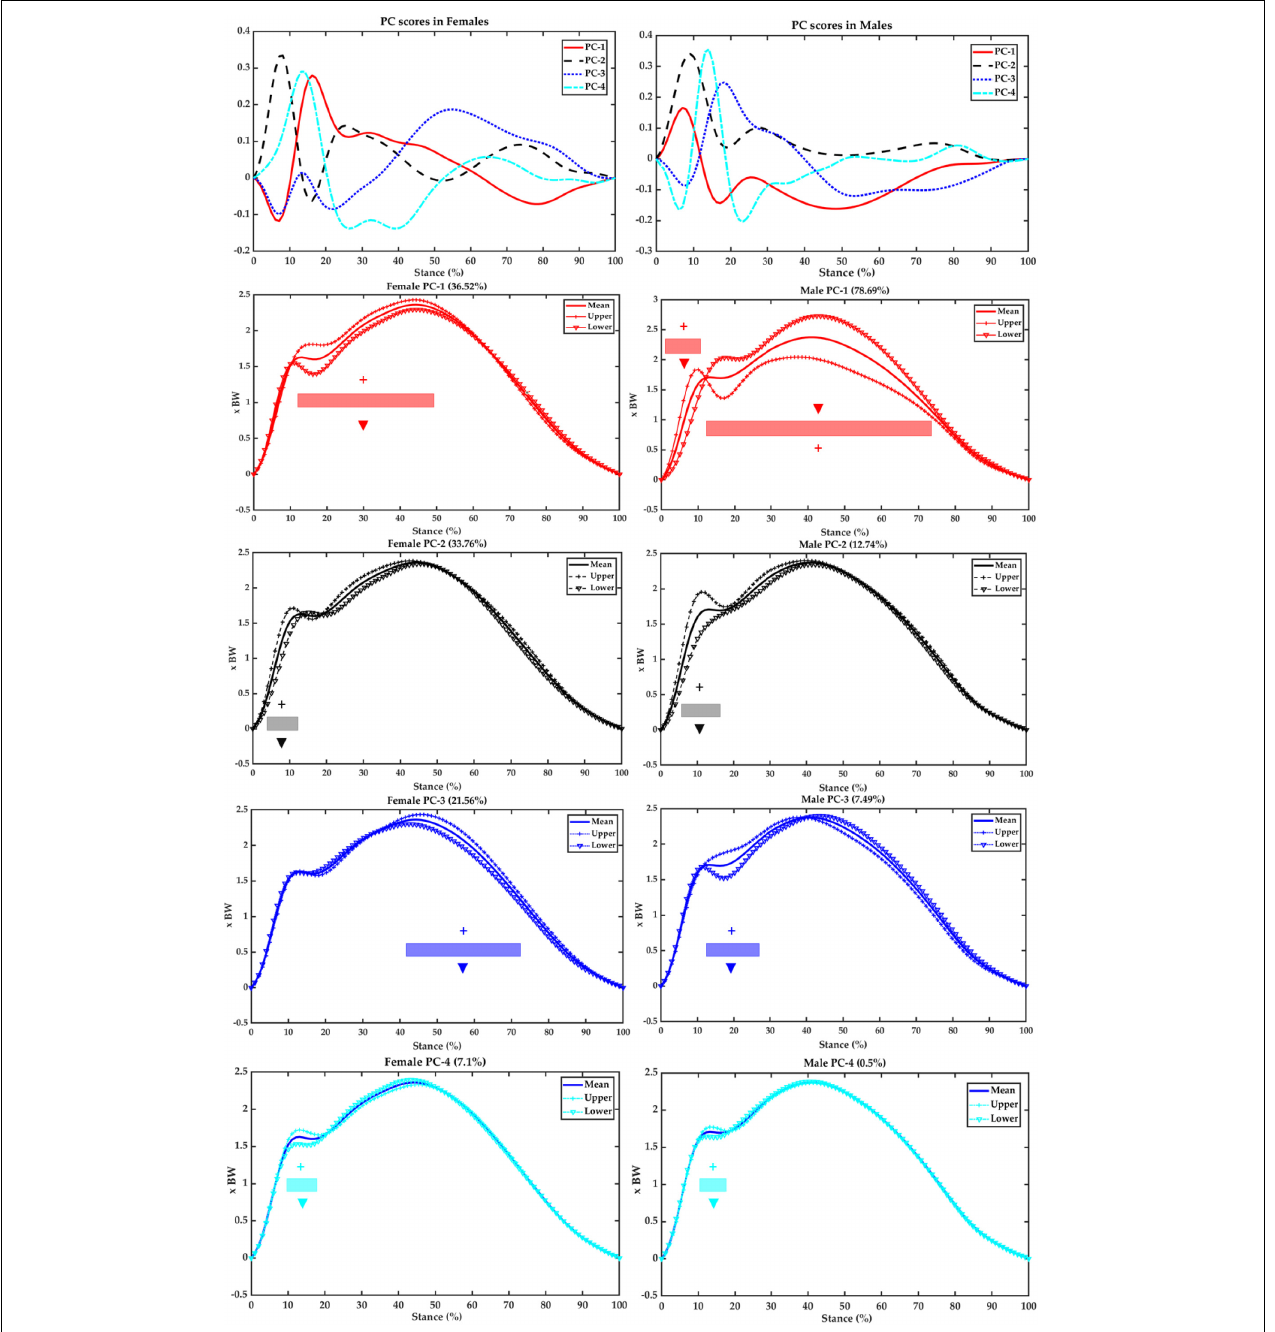
FIGURE 6 | Scores of the first four PCs (first row) and variances of PC1 (second row in red), PC2 (third row in black), PC3 (fourth row in blue), and PC4 (fifth row in cyan) against the mean vertical GRF of the female (left) and male (right) runners. Upper (plus SD) limit (with symbol “+”) and lower (minus SD) limit (with symbol “ (cid:116) ”) highlight the contribution of plus/minus of the scores and coefficients for this